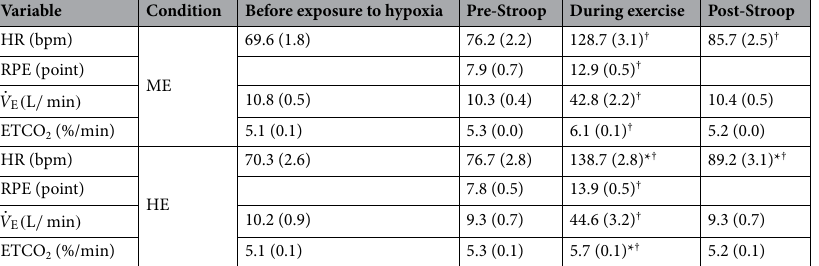
˙ V E , ventilation;